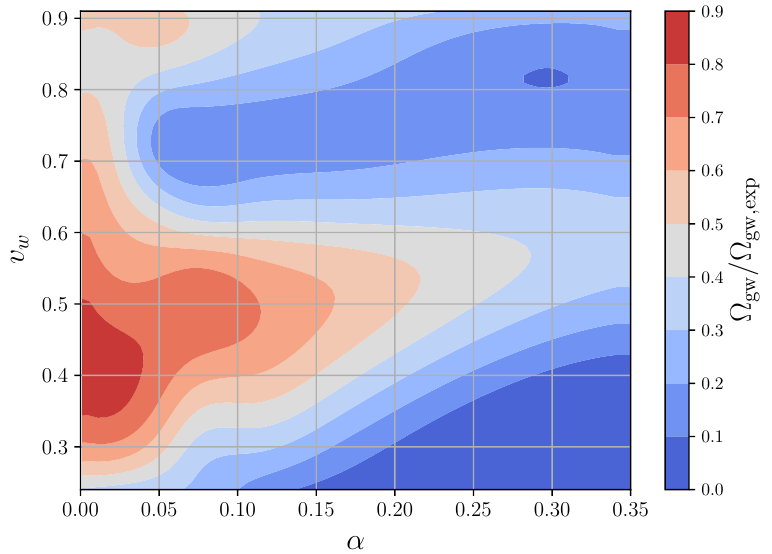
Figure 17 . Contours of suppression to Ω gw in the form of the ratio Ω gw to Ω gw,exp , where Ω gw,exp is the expected power computed according to the LCWG